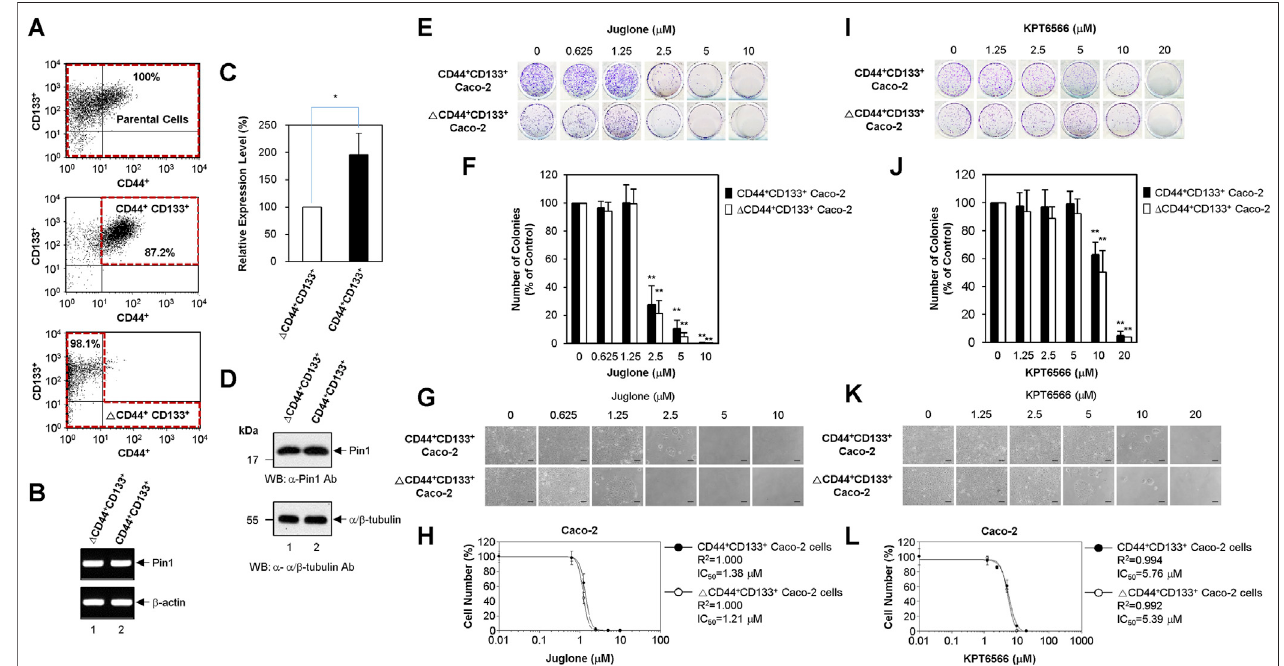
FIGURE 5 | Suppression of CD44 + CD133 + tumor-initiating Caco-2 cell proliferation by Juglone or KPT6566. (A) Flow cytometric cell sorting of parental Caco-2 cells (top panel), CD44 + CD133 + Caco-2 cells (middle panel), and Δ CD44 + CD133 + Caco-2 cells (bottom panel) double-labeled with anti-CD44 and anti-CD133 antibodies. Sorted tumor- initiating Caco-2 cells (CD44 + CD133 + subpopulation) and non-tumor-initiating Caco-2 cells ( Δ CD44 + CD133 + subpopulation) were re-analyzed immediately following the fi rst sorting. The percentages refer to the purity of the selected subpopulation contained in the sorted fraction. (B) Expression of Pin1 mRNA by the CD44 + CD133 +